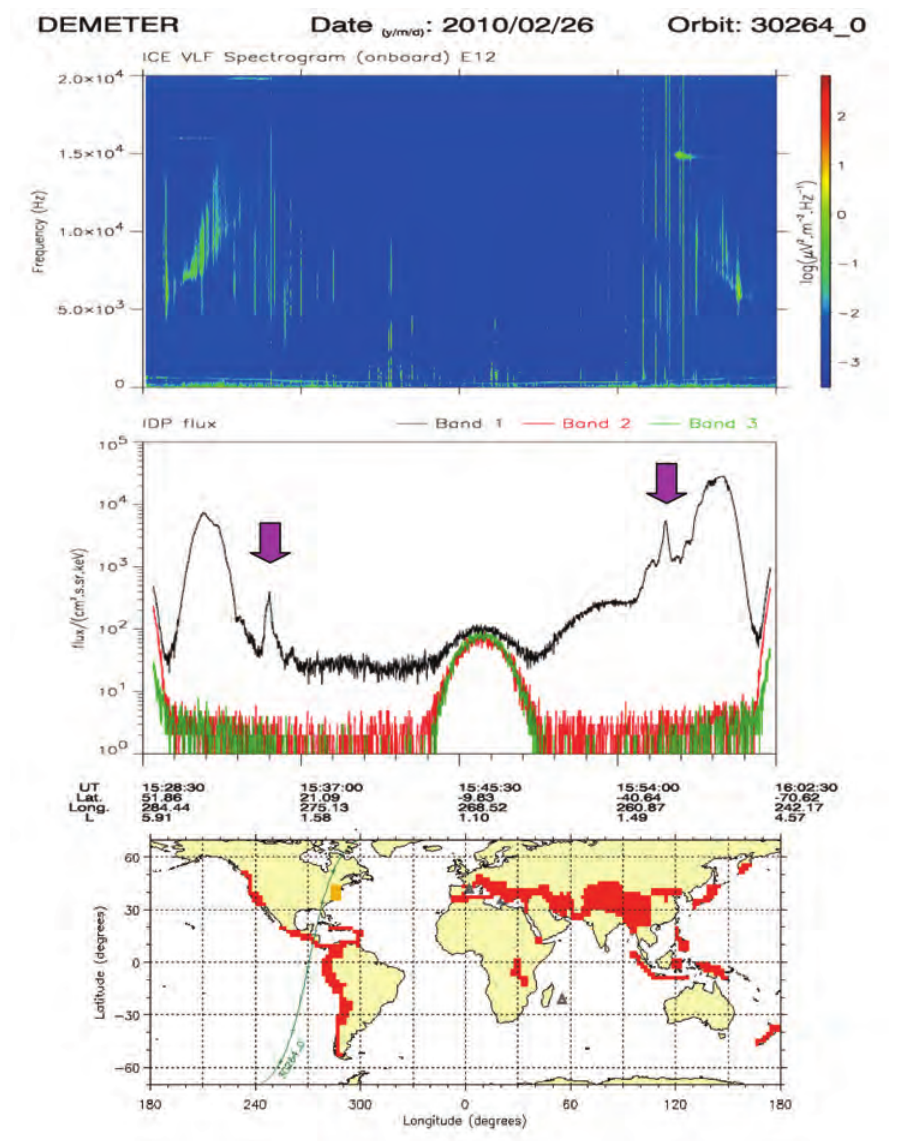
Figure 2. Observations from the DEMETER satellite during an upward semi-orbit, for the day before the giant earthquake of February 27, 2010, in Chile (M = 8.8, 287.1˚E, 36˚S). Details as for legend to Figure 1. Two EBs were observed in the dayside upper ionosphere, with one above the future epicenter and a conjugate one in the north